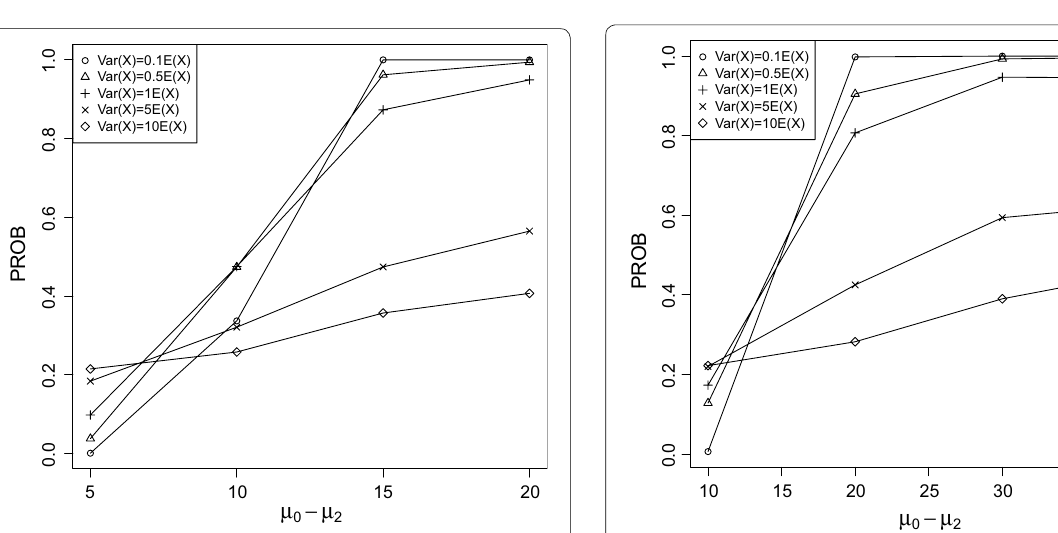
Fig. 5 PROB of the CPCAT; µ 0 = 100 ; decreasing